Question: Write a single sentence explaining what this figure depicts.
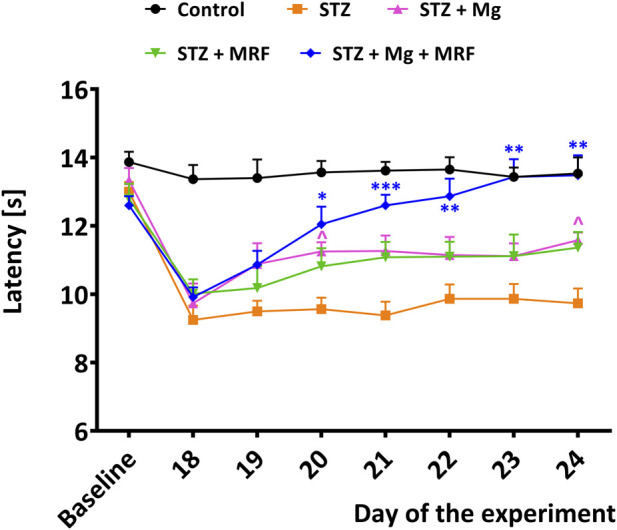
Answer: Effect of magnesium on the antinociceptive activity of morphine in neuropathic rats. Pain thresholds, expressed in seconds, were measured before streptozotocin administration (baseline threshold) and then before injection of the tested compounds for 7 consecutive days (corresponding to days 18–24 of the experiment). Data were analyzed using two-way repeated-measures ANOVA followed by Tukey’s multiple comparisons test. Significant differences are indicated as follows: *** p < 0.001; ** p < 0.01; * p < 0.05 STZ+Mg+MRF vs. STZ and ^ p < 0.05 STZ+Mg vs. STZ. Values are presented as mean ± SEM; n = 6 rats for each group.